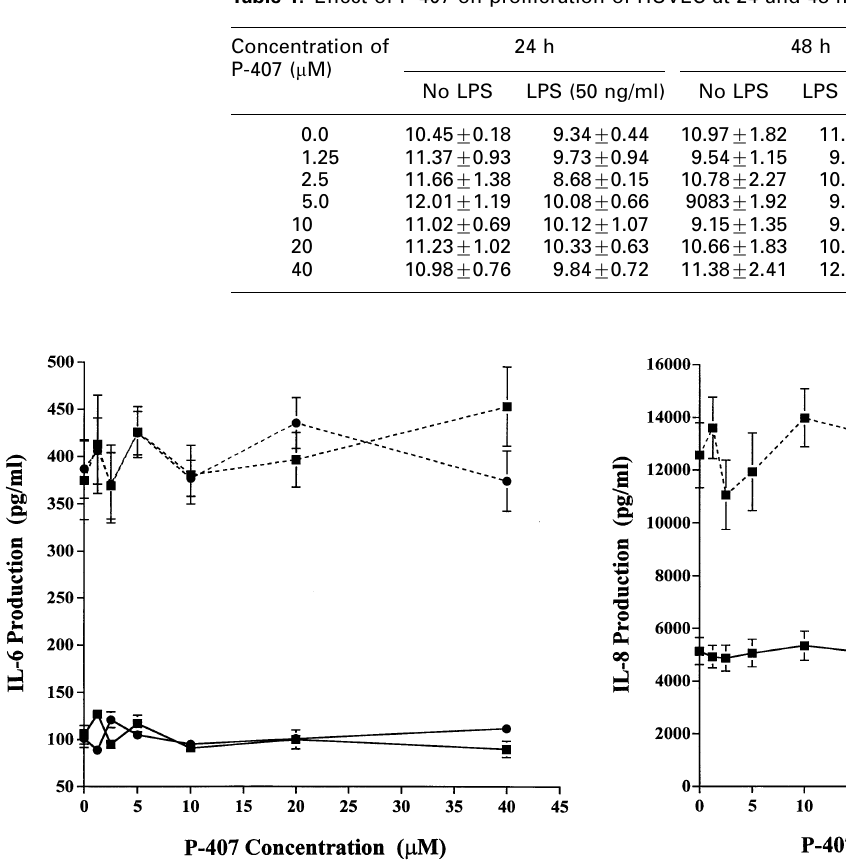
FIG. 2. Effect of P-407 on IL-8 release from HUVEC. Concen- tration of IL-8 in the absence (solid line, j ) and the presence (dashed line, j ) of LPS (50 ng/ml) at 24